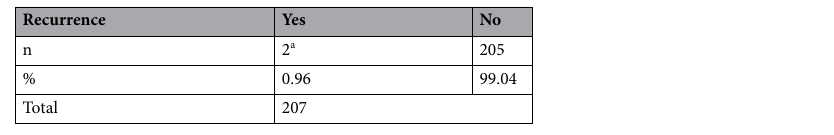
Table 8. Recurrence. a Both recurrences were diagnosed in 1 patient (0.7%) with an associated diagnosis of recurrent colorectal